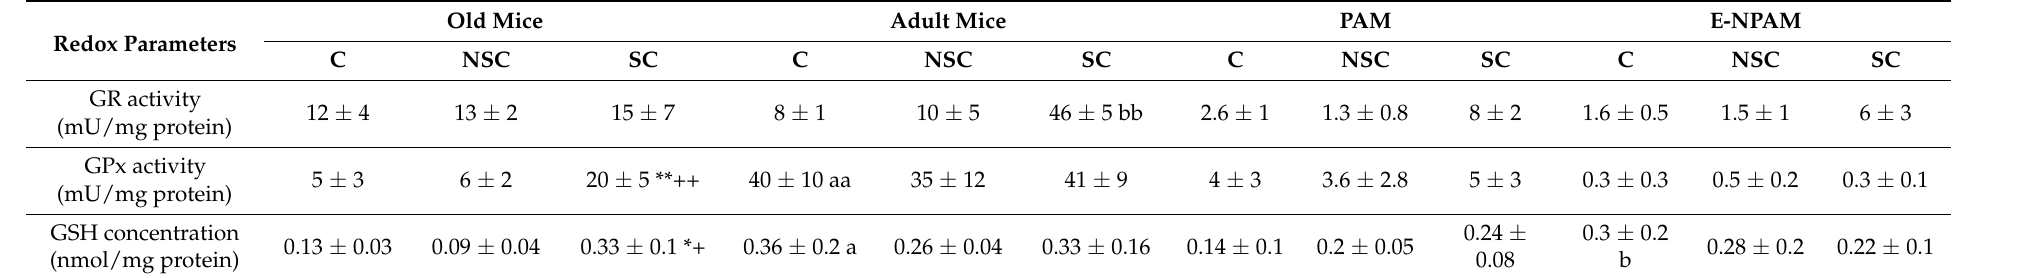
Table 3. Redox parameters in peritoneal leukocytes of old mice/PAM and adult mice/E-NPAM after cohabiting for 15 min/day for 2